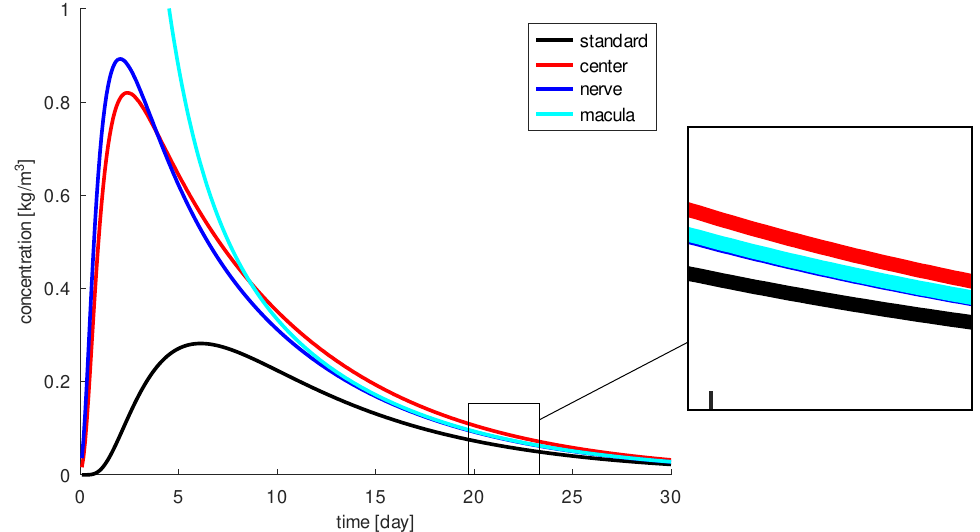
Figure 5. The drug concentration at the macula for different injection positions over time: the trajectory for the standard injection (black), for the injection into the center of the vitreous (red), for the injection near the optic nerve (blue) and for the injection near the macula (light